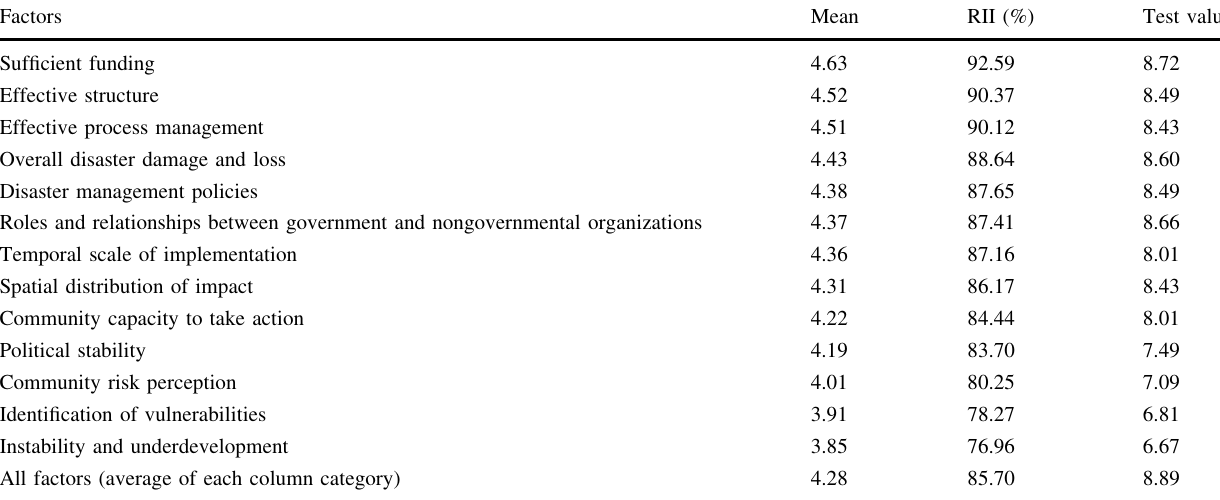
Table 3 Factors influencing organizational behavior in the Gaza Strip